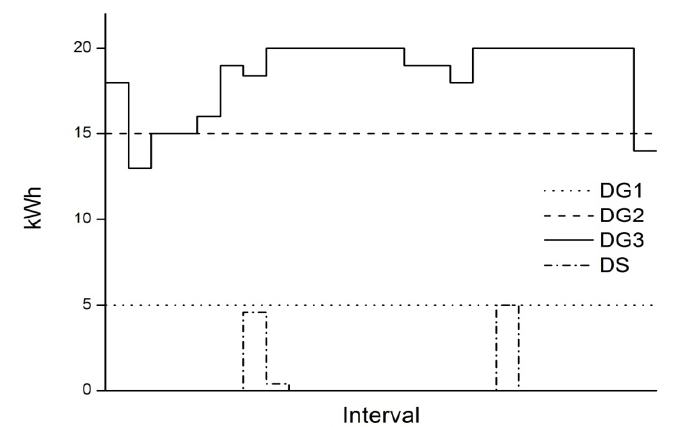
Figure 8. Supply operated by the system.